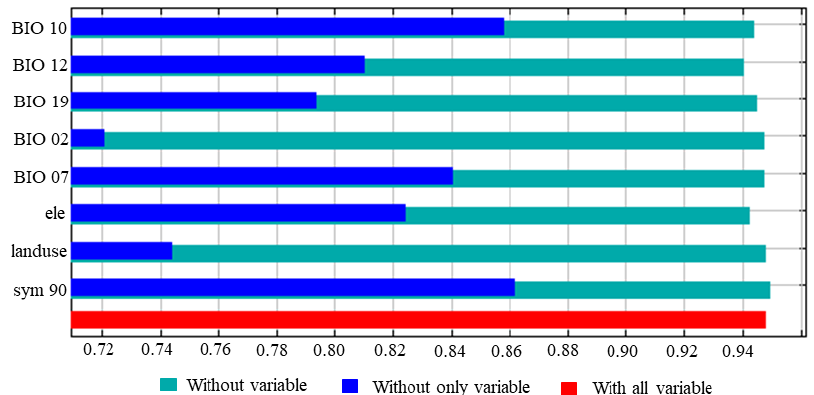
Figure 3. Jackknife test for evaluating the relative importance of major environmental variables for V. uliginosum .